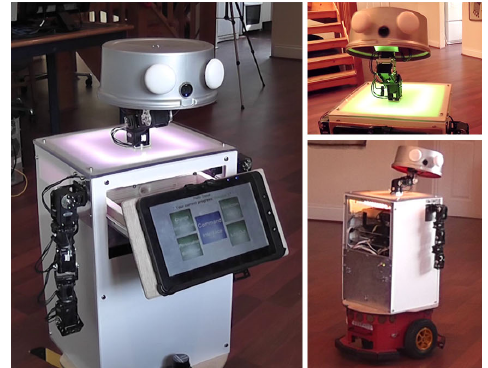
Figure 2: The UH Sunflower Robot SF1 – (left) extends its GUI for interaction, (top-right) performing attention seeking behaviour to attract user’s attention, (lower right) exhibits a non-verbal dog- inspired looking back behavior used in [41].